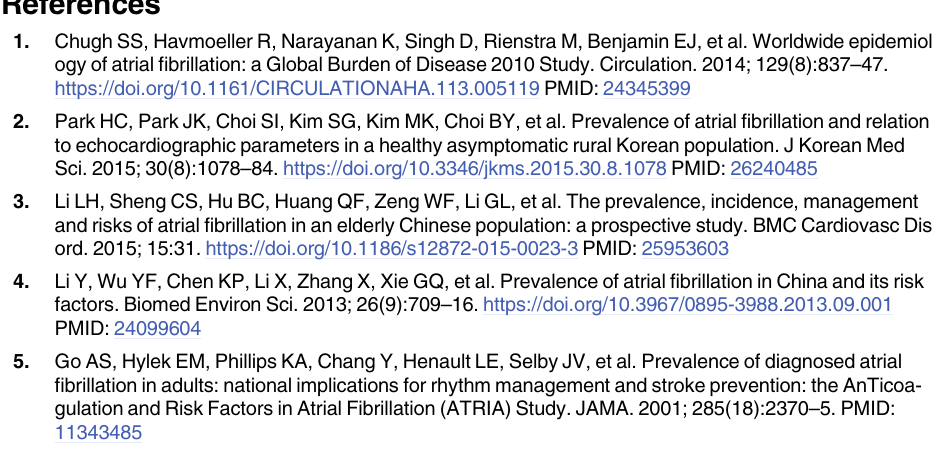
S1 Table. Baseline characteristics of the subjects according to the presence of atrial fibrilla- tion. S2 Table. Baseline characteristics of subjects according to the total cholesterol variability (TC-SD). S3 Table. Baseline characteristics of subjects according to the total cholesterol variability